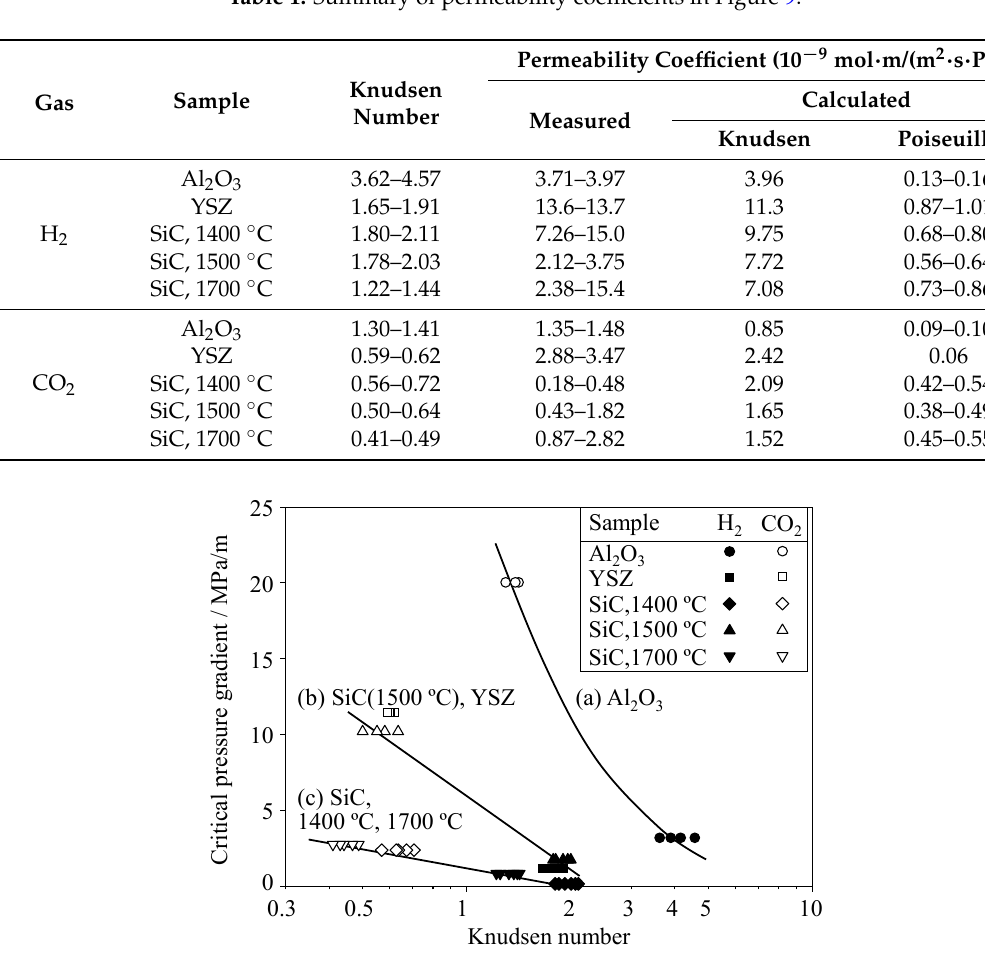
Table 1. Summary of permeability coefficients in Figure 9.